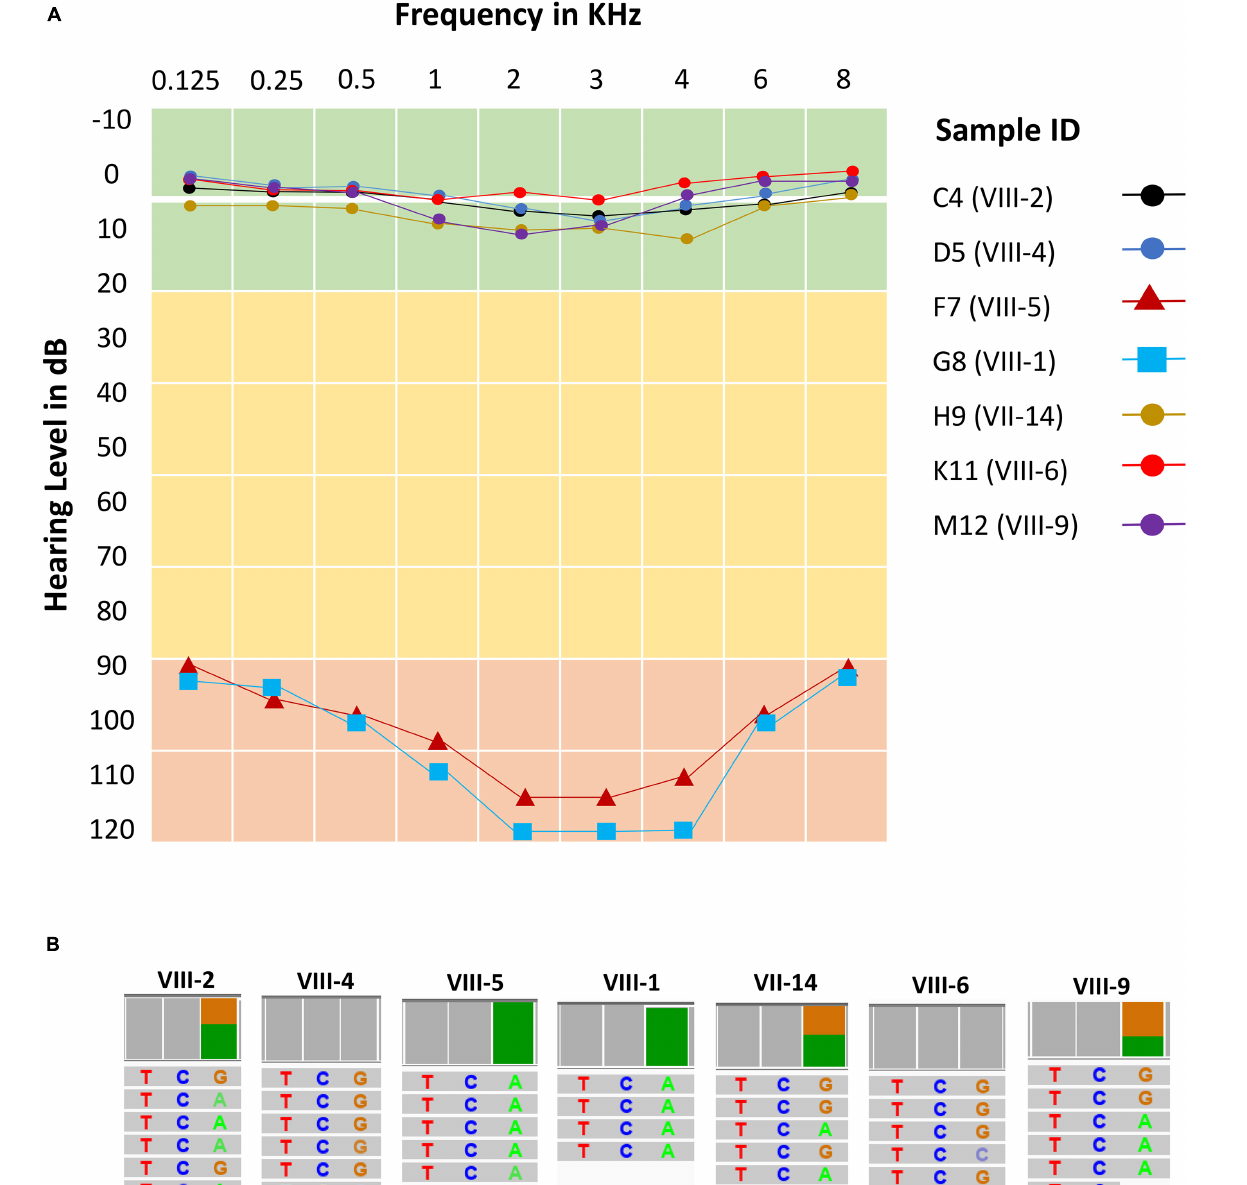
conservation at the site of OTOF mutation